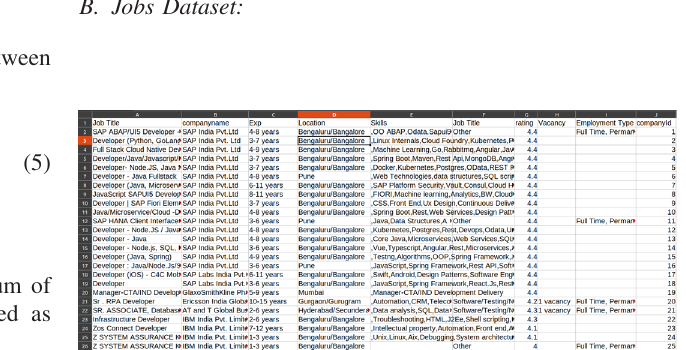
Fig. 3. Jobs Dataset